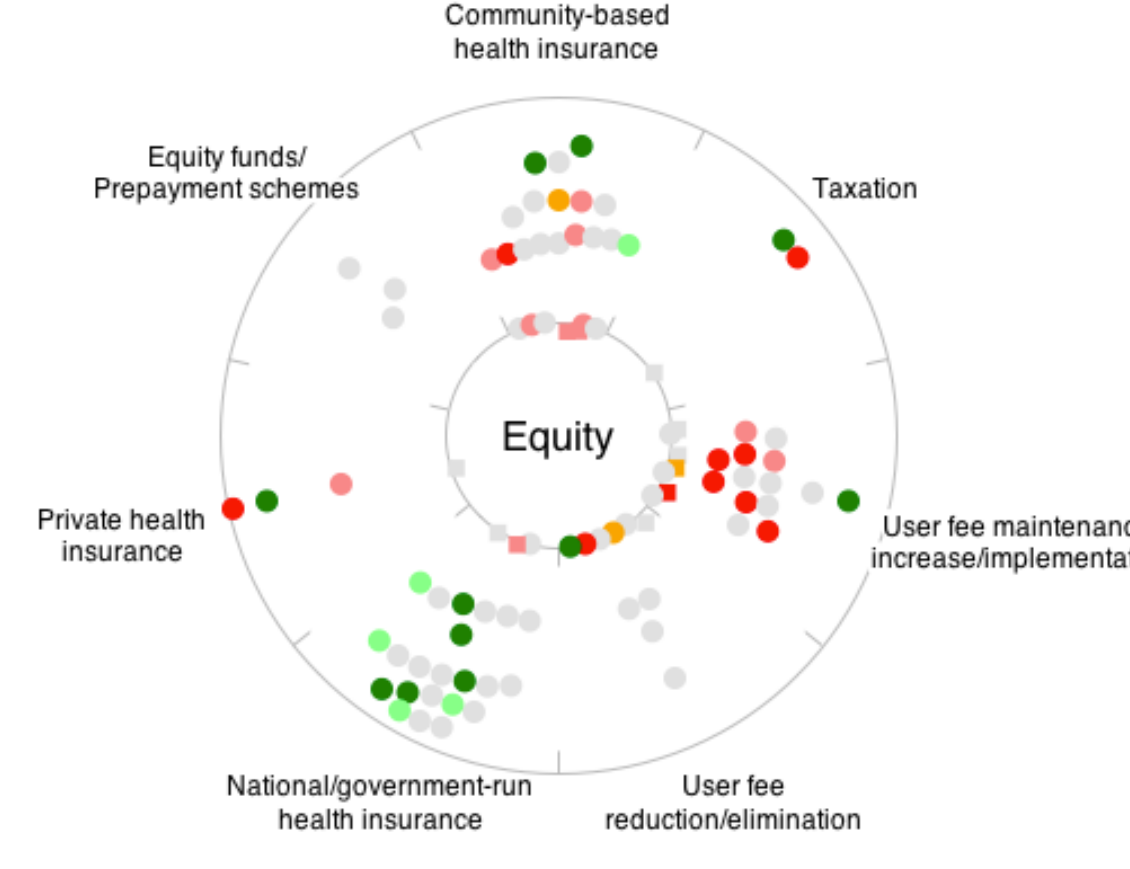
Figure 3. Example of a 'scattar' plot showing the available evidence of impact of each financing tool on promoting equity in Uganda. Each dot represents a single study and its colour represents the reported impact on the specified